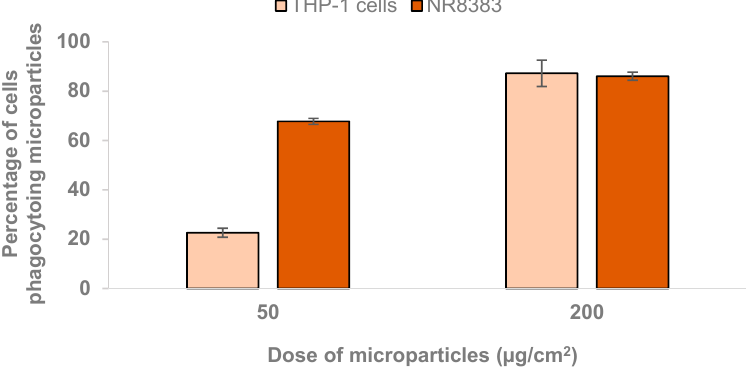
Figure 8. Uptake of fluorescently-labelled fucoidan (FUC) microparticles by macrophage-differentiated THP-1 cells and NR8383 cells exposure to 50 µg/cm 2 and 200 µg/cm 2 , for a period of 2 h. Results are expressed as mean ± SEM ( n ≥ 3).